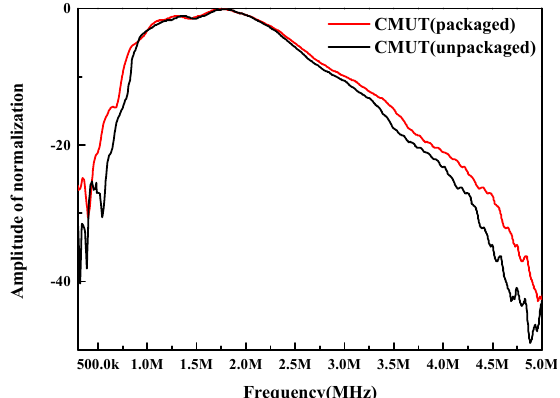
Figure 13. Schematic diagram of pulse echo device test.